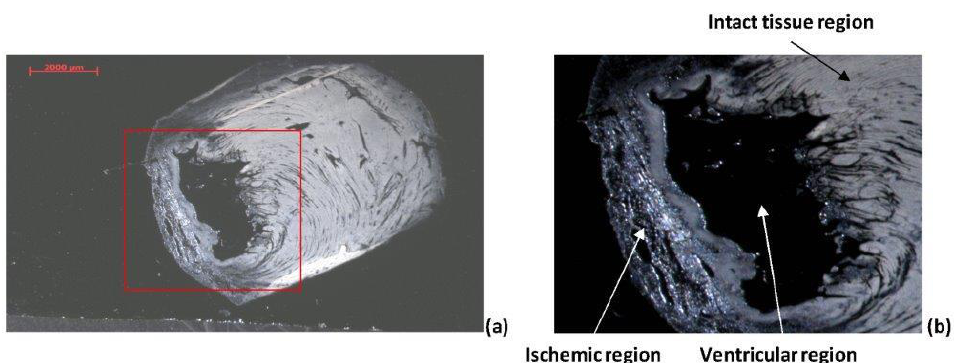
Figure 3. Optical image of ( a ) the full heart tissue section, and ( b ) the magnification of the region close to the ventricle showing the damaged tissue (ischemic area).